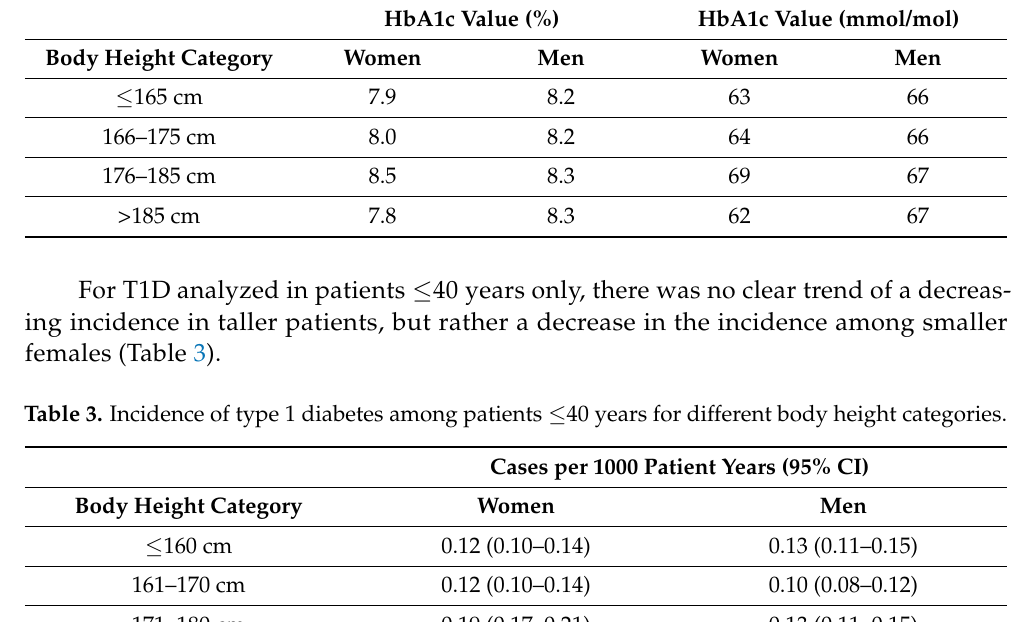
Table 2. Comparison of HbA1c values between different body height categories for men and female patients. HbA1c Value (%)